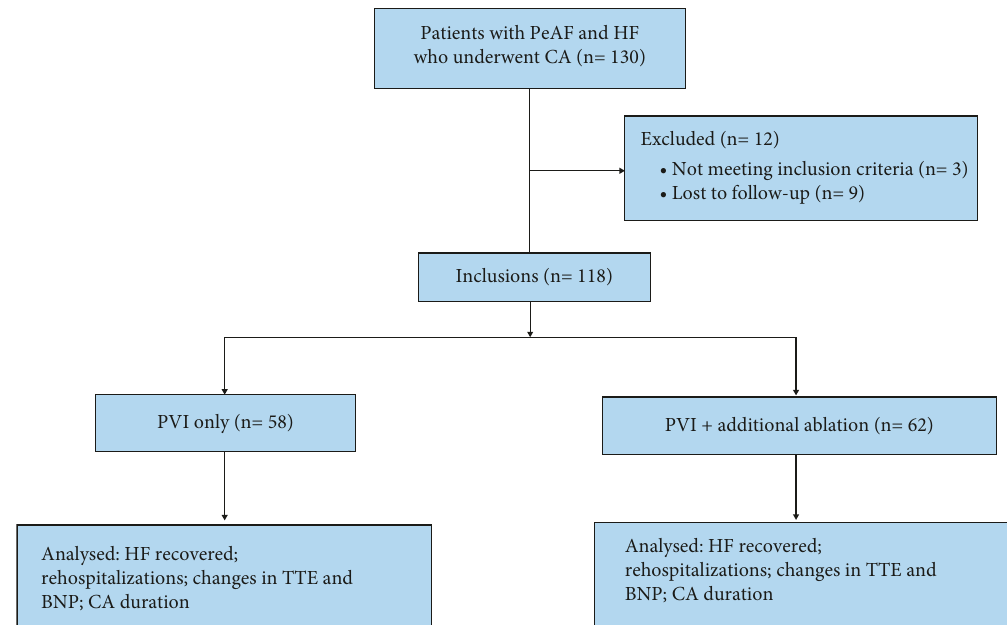
Figure 1: Flowchart of the included and analyzed patients. Of 118 patients with PeAF and HF enrolled, 58 patients received PVI alone and 62 patients received PVI and additional